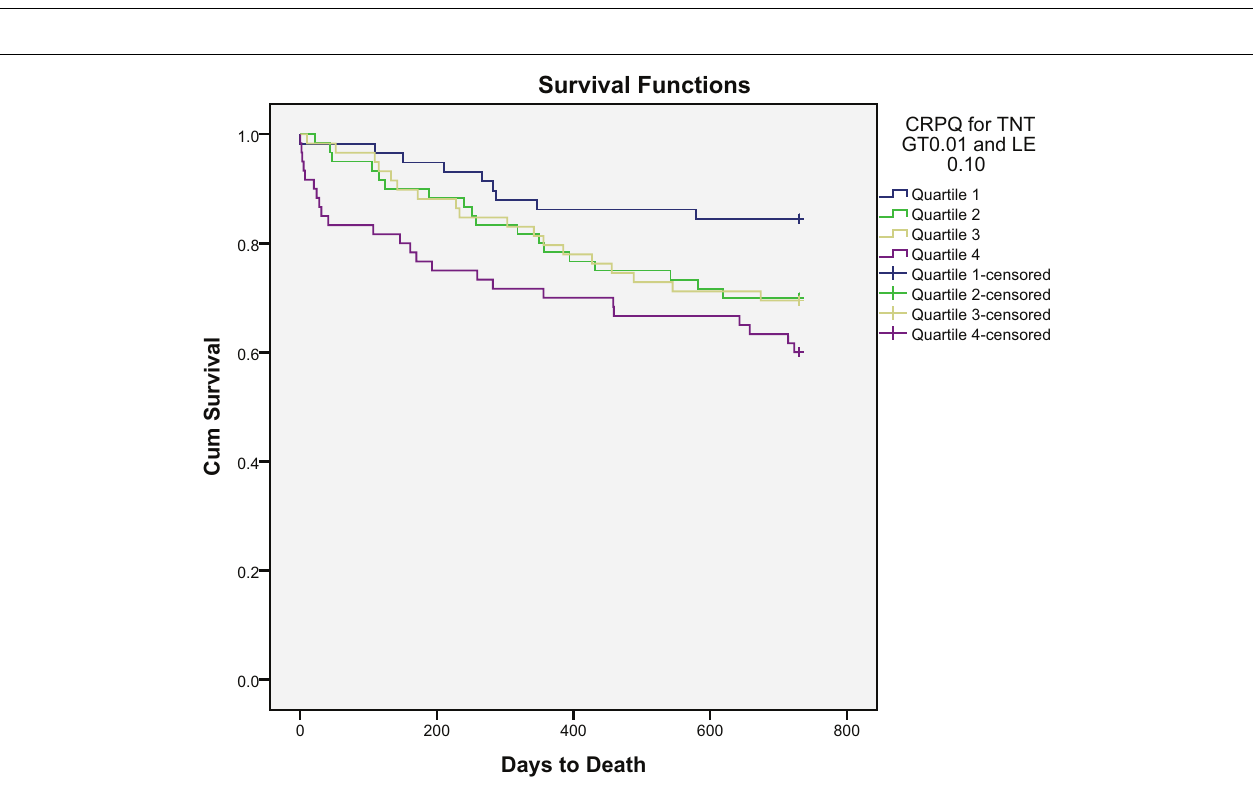
FIGURE 1 | Kaplan–Meier plot of time to all-cause mortality within 2years by BNP quartiles .